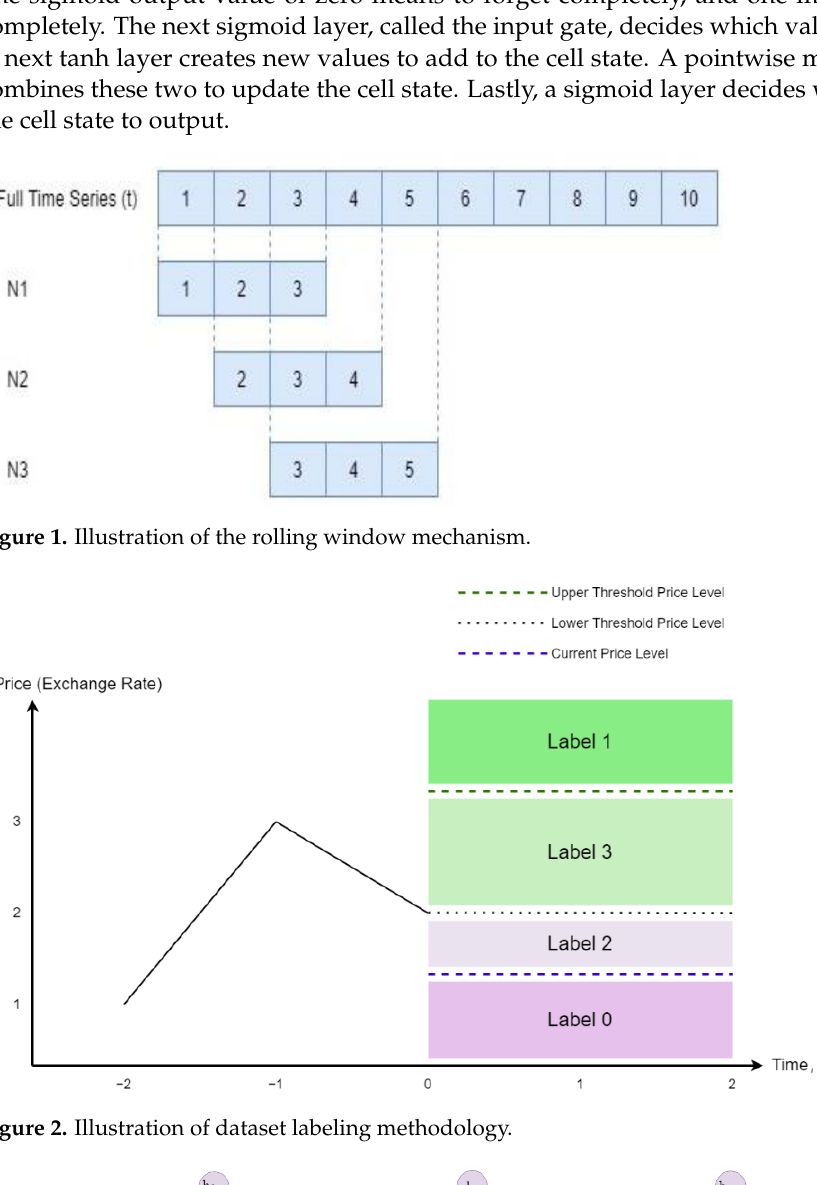
Figure 2. Illustration of dataset labeling methodology.